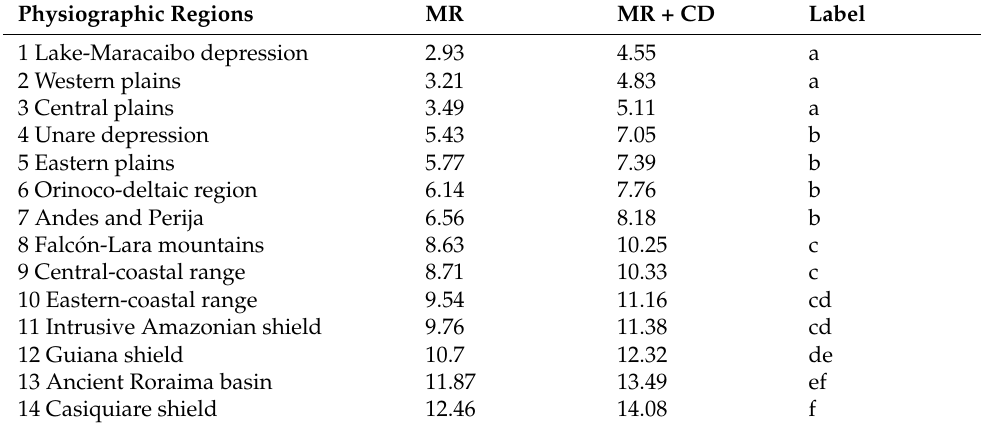
Table 4. Mean ranks (MR) computed by the Nemenyi test to the projected decreases in annual mean precipitation for the different physiographic